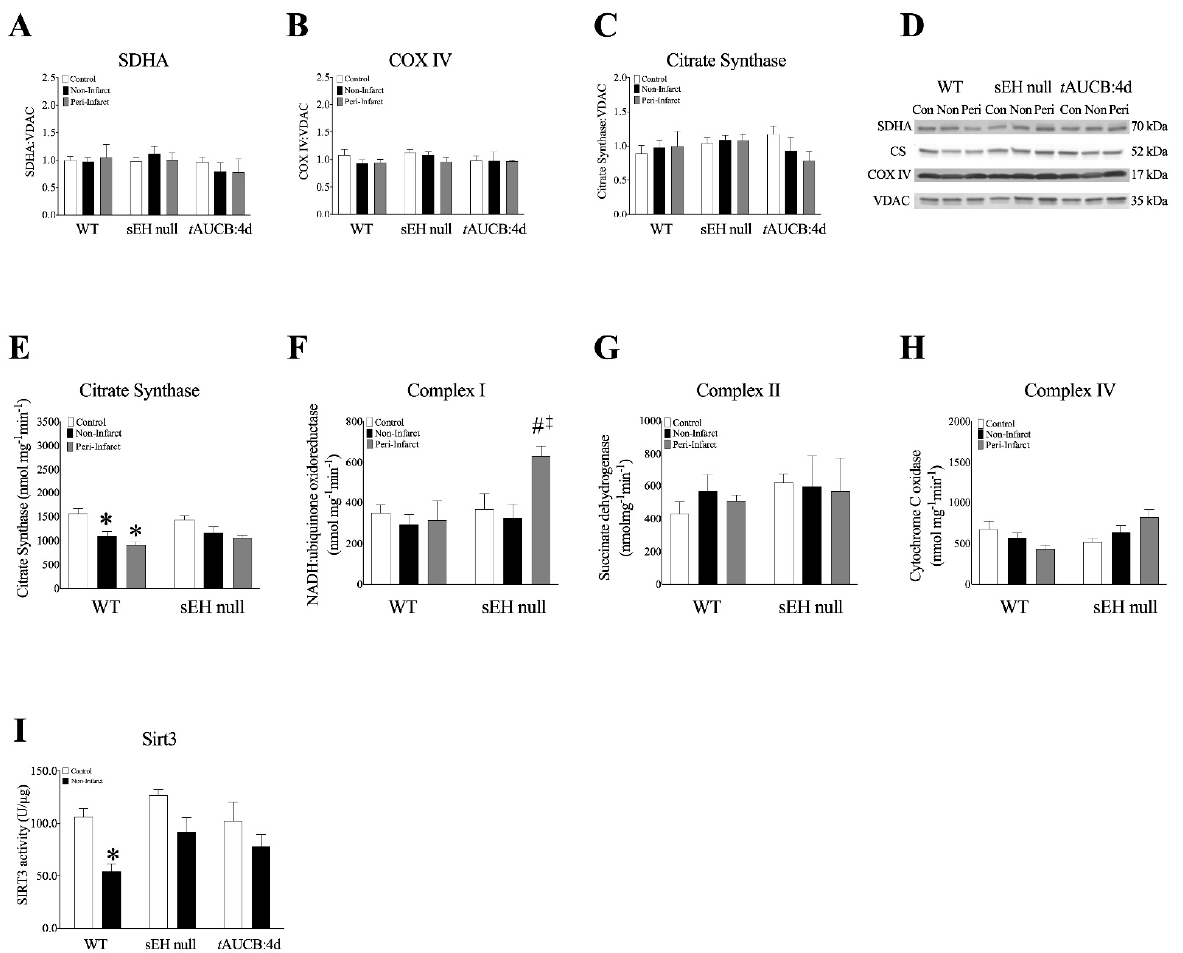
Figure 5. Electron transport chain protein expression and activity in female mouse hearts. ( A – D ) Protein expression of key mitochondrial ETC enzymes in mitochondrial fractions from female mouse left ventricular tissue. ( A ) Succinate dehydrogenase A (SDHA) expression, ( B ) Cytochrome C oxidase (COX IV) expression, ( C ) Citrate synthase (CS) expression, ( D ) representative blots. All proteins were normalized to VDAC. ( E – H ) ETC complex activity (nmol mg − 1 min − 1 ) in WT and sEH null female left ventricular tissue. ( E ) citrate synthase (CS) activity, ( F ) Complex I (NADH:ubiquinone oxidoreductase) activity, ( G ) Complex II (succinate dehydrogenase, SDH), and ( H ) Complex IV (cytochrome C oxidase, COX IV). ( I ) Cardiac SIRT3 activity was determined in mitochondrial fractions in mice hearts using a SIRT3 fluorescent assay kit. Data are represented as mean ± SEM, N = 3–5. Data are represented as mean ± SEM, n = 3–5. p ≤ 0.05; * vs. Control, # vs. WT group, ‡ vs. non-infarct group.